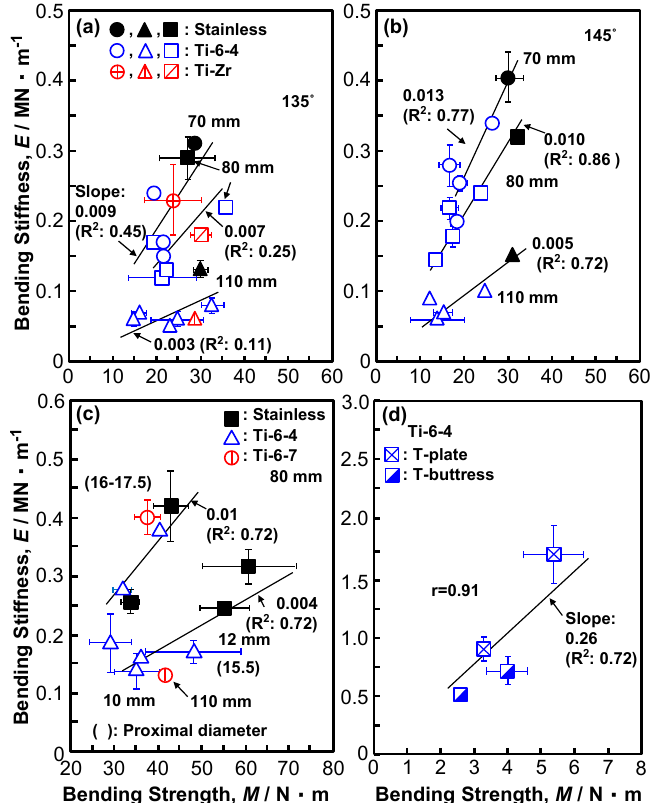
Figure 4. Relationship between bending stiffness and bending strength obtained from compression bending tests. ( a , b ) CHSs, ( c ) short femoral nails, and ( d ) epiphyseal plates.